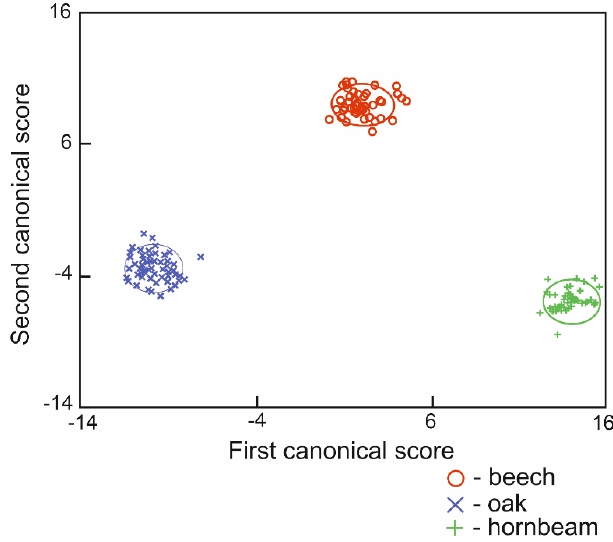
Figure 7. Canonical scores of topsoil samples from oak forests, beech forests and hornbeam/maple- dominated forests.